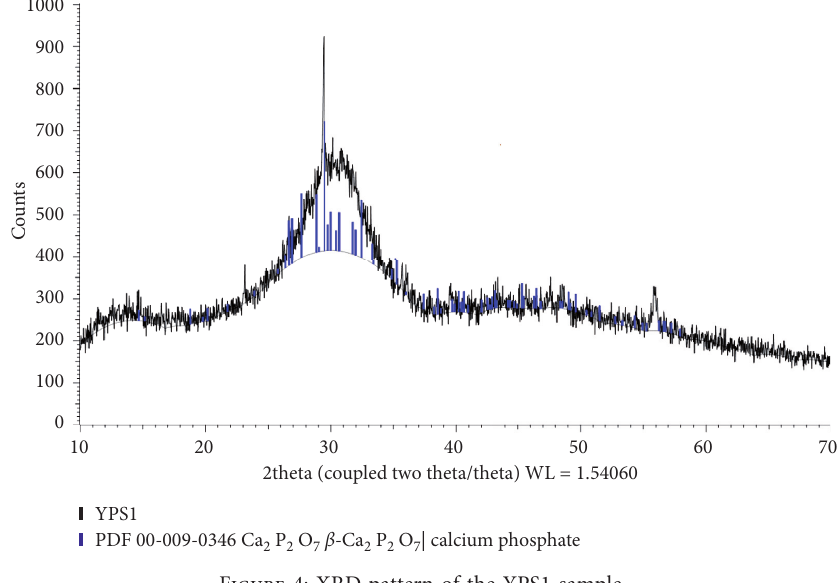
Figure 4: XRD pattern of the YPS1 sample.